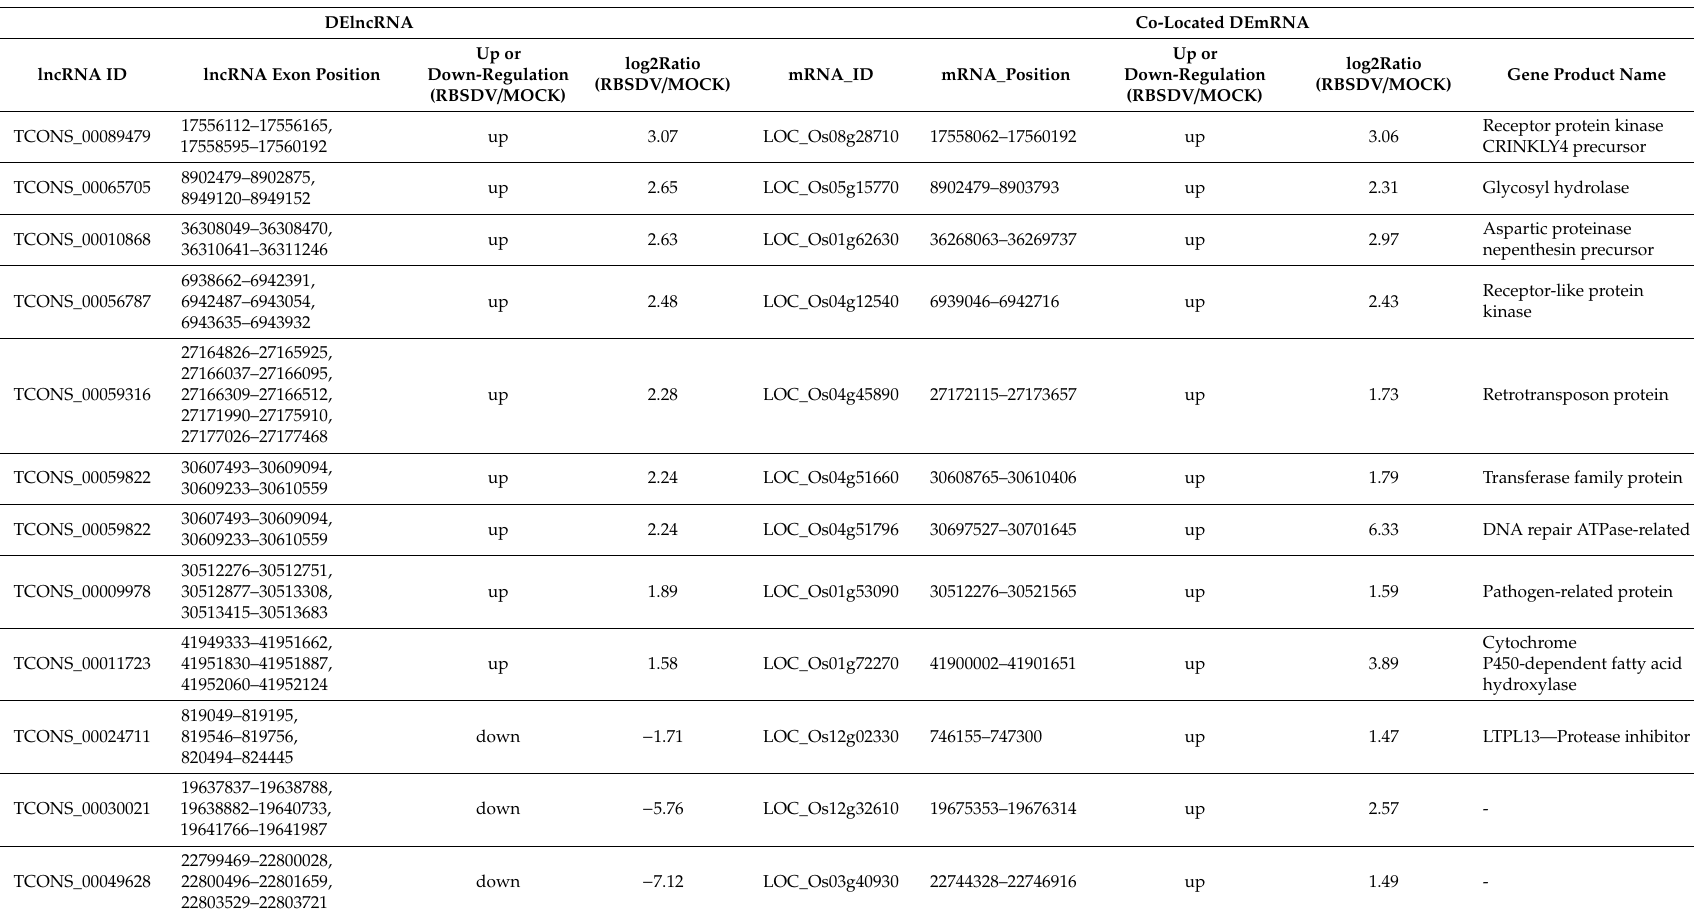
Table 3. The co-located DElncRNA–DEmRNA